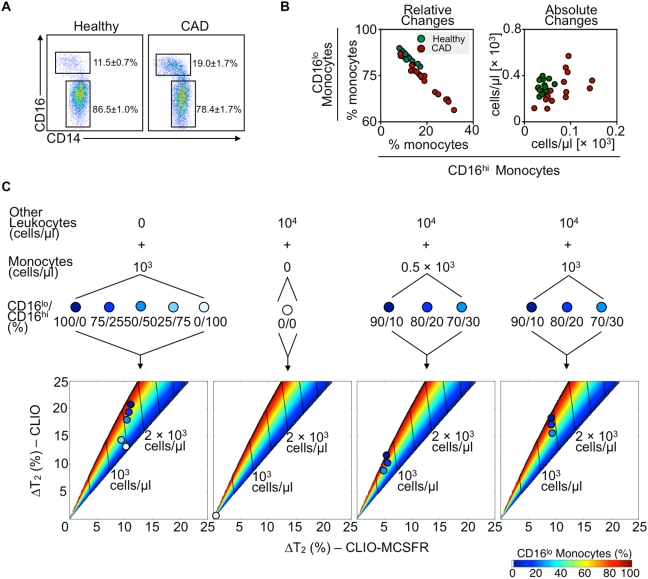
Magnetic nano-sensors enumerate monocyte subset variations that occur in atherosclerotic patients.A. Representative flow cytometry dot plots of monocyte subsets from healthy volunteers and patients with documented coronary artery disease (CAD). Numbers depict percentage of subsets in both groups. Mean±SEM. B. Plots depict percentage (left plot) and absolute numbers (right plot) of CD16lo and CD16hi monocytes from healthy volunteers (green dots) and patients with CAD (red dots). C. Validation of the enumerative mathematical model with varying number and percentage of monocyte subsets. Data show goodness of fit of defined numbers of monocytes alone (left panel), other leukocytes (middle-left panel) and combinations of leukocytes and monocytes (right two panels). Different proportions of monocyte subsets (CD16lo/CD16hi (%)) are color-coded and their fit is depicted on the two-dimensional T2 maps.